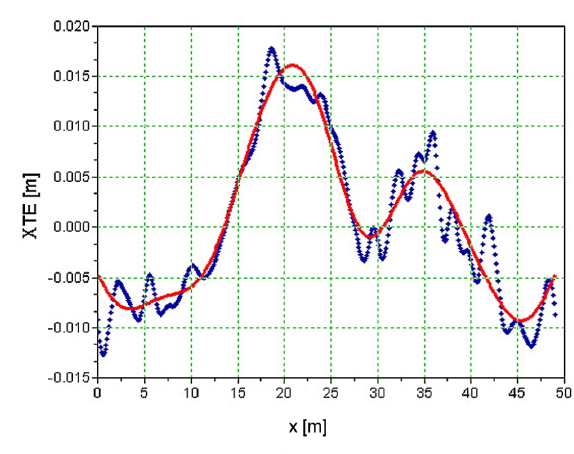
Figure 9: Finally approved signal of XTE representing the selected straight section.